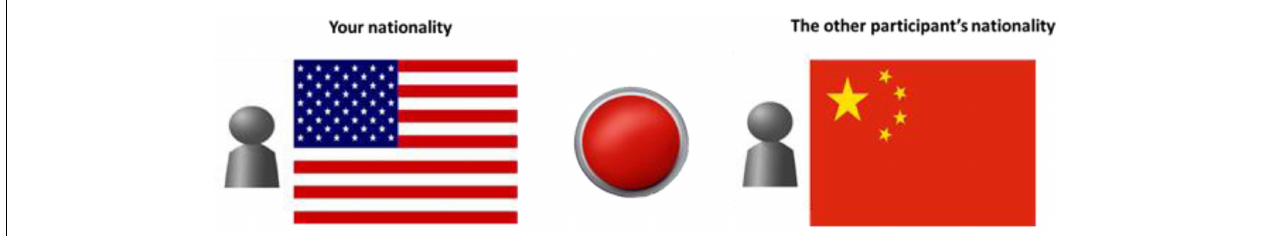
FIGURE 1 | A stimulus for a PSG decision: the United States–China PSG. American participants decided whether to click the red button within 30-s, facing an anonymous Chinese participant.